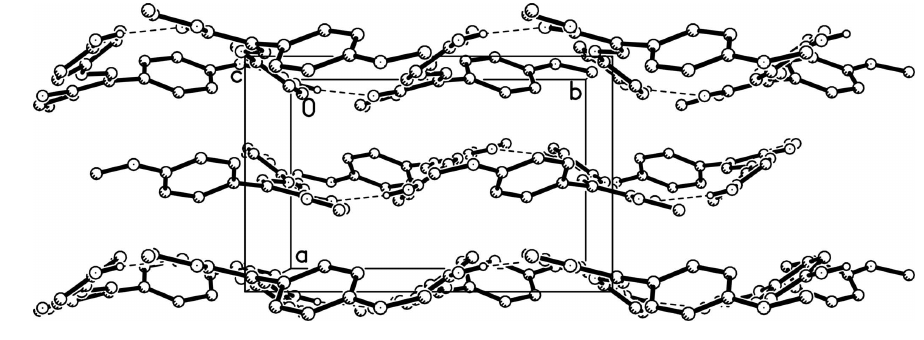
The molecular structure of the title compound, showing 30% probability displacement ellipsoids and the atom-numbering scheme.